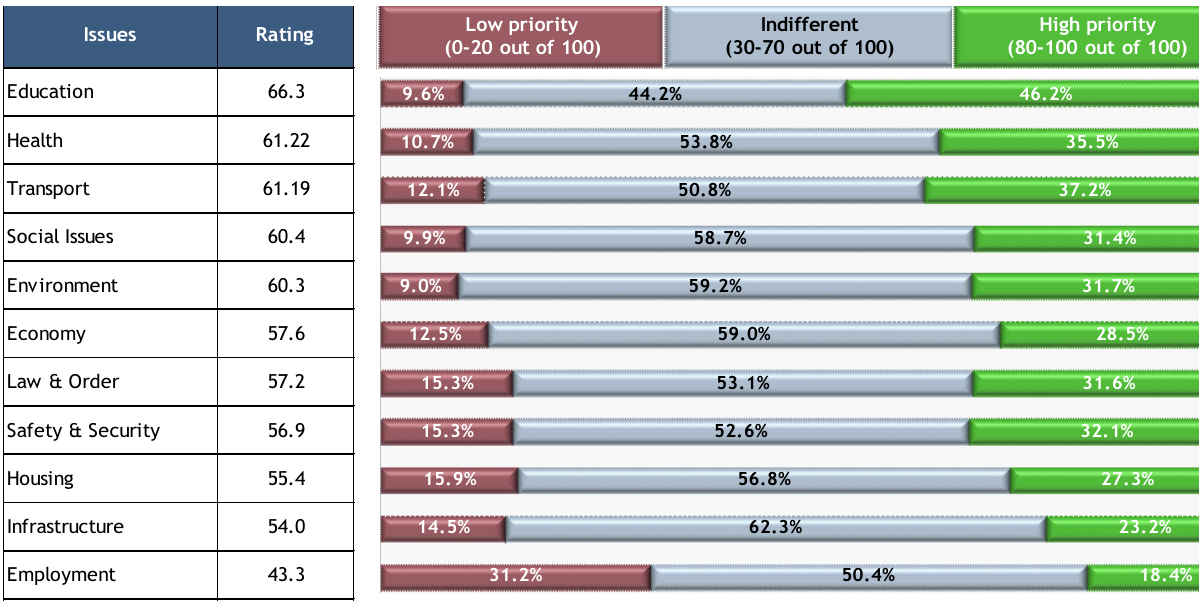
FIGURE 5: Rating of national issues.